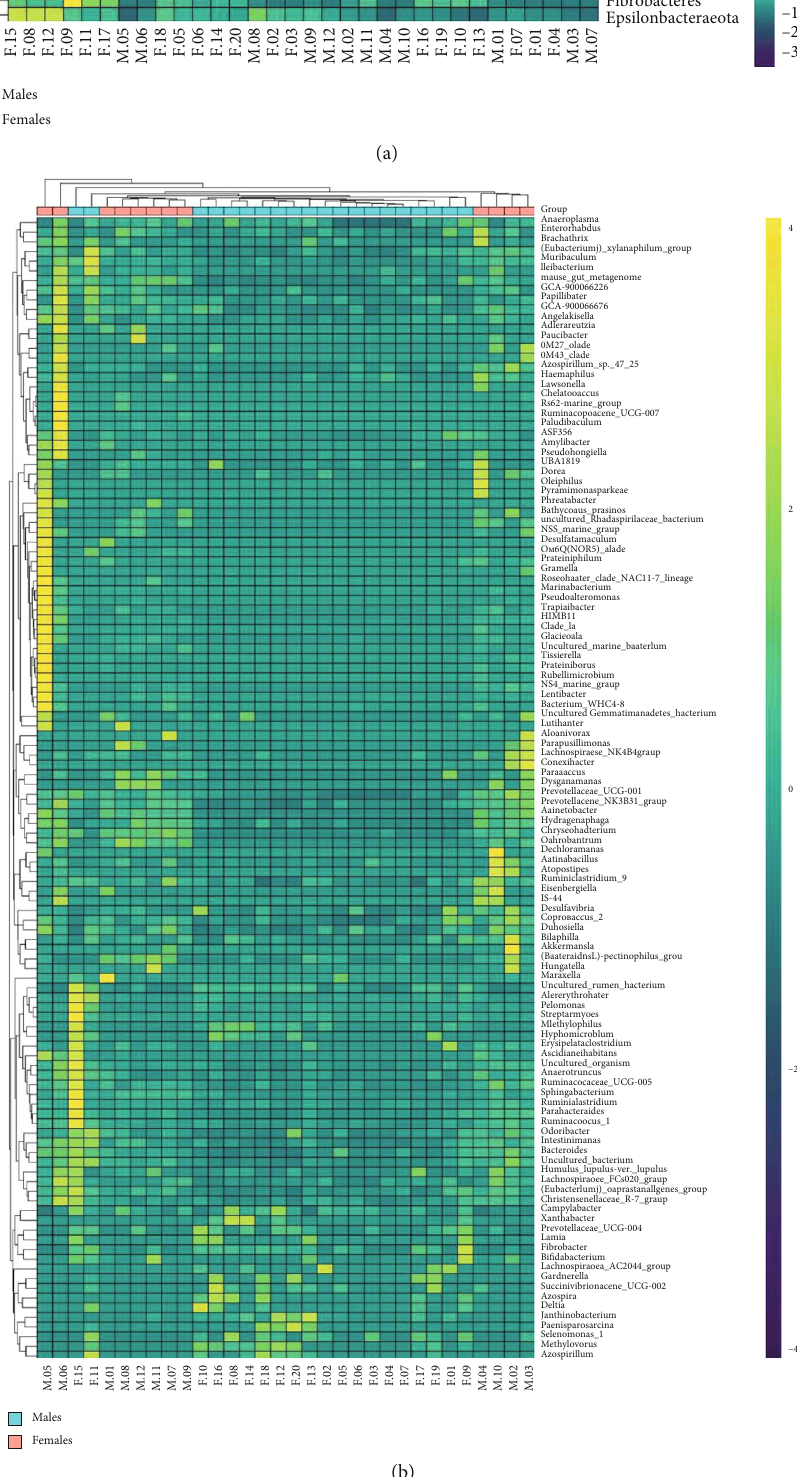
Figure 4: Heat map of di ff erential oral microbiomes between elderly males and females with stage 1 periodontitis. (a) Phylum level. (b) Genus level. The sample information (group and number) and species annotation information are displayed on the horizontal axis and vertical axes, respectively. Colors indicate the Spearman rank